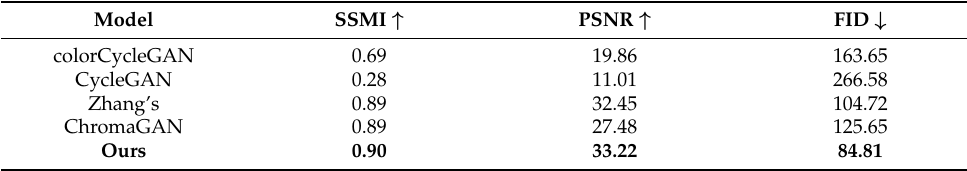
Table 5. Coparison of different